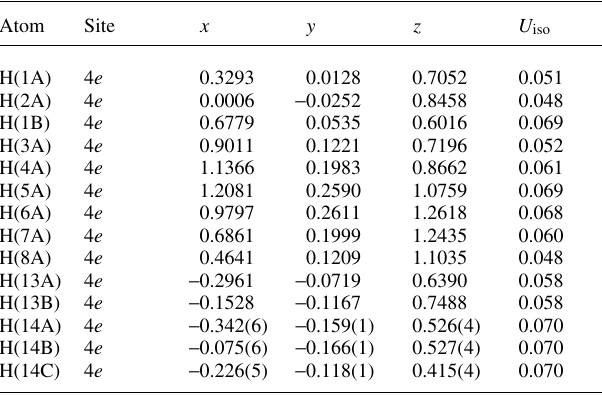
Table 2. Atomic coordinates and displacement parameters (in Å 2 )